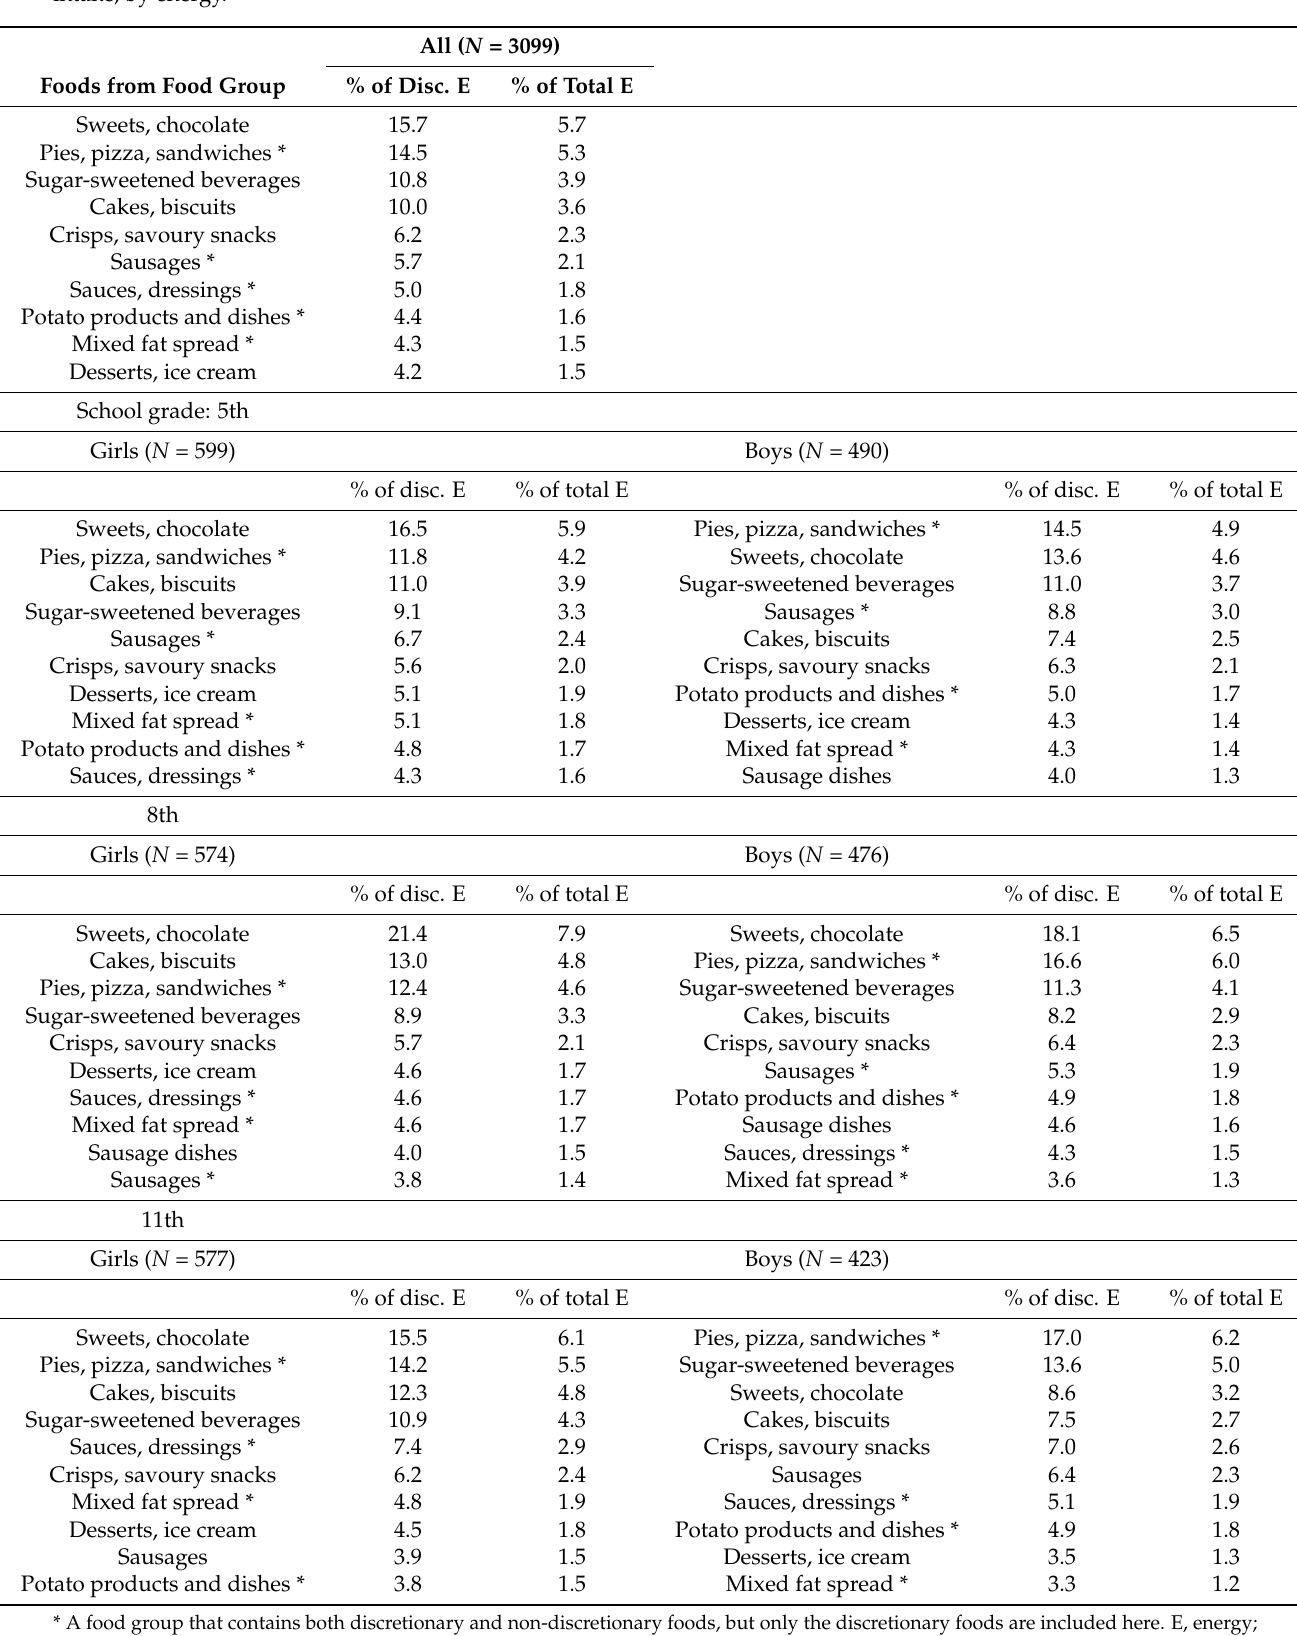
Table 3. Contribution of discretionary foods/beverages to total intake of all foods/beverages and to total discretionary intake, by